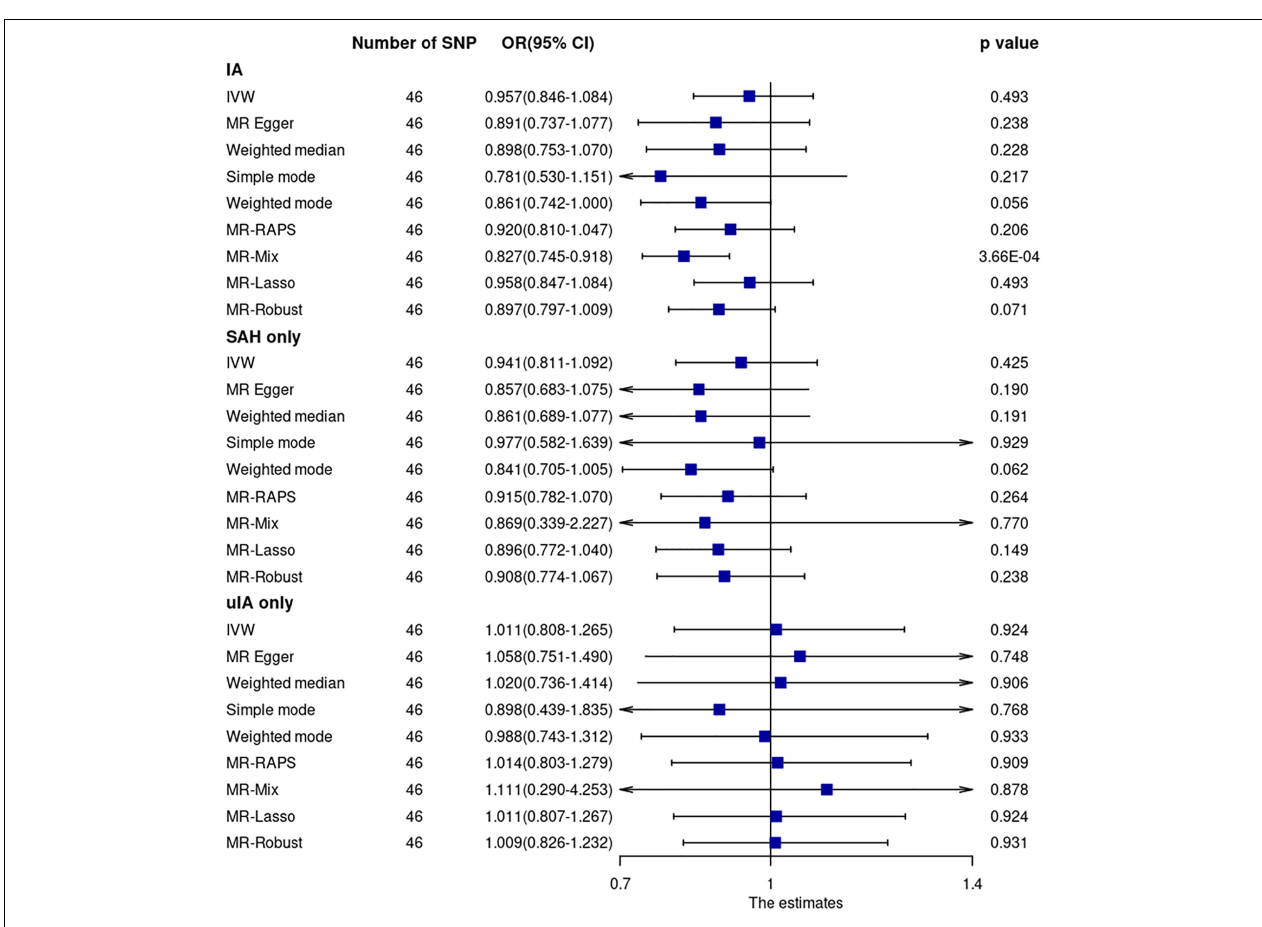
FIGURE 3 | Mendelian randomization analyses of CRP levels on risk of IA. CI, confidence interval; IVW, inverse variance weighted; OR, odds ratio; SAH, subarachnoid hemorrhage; SNP, single nucleotide polymorphism; uIA, unruptured intracranial